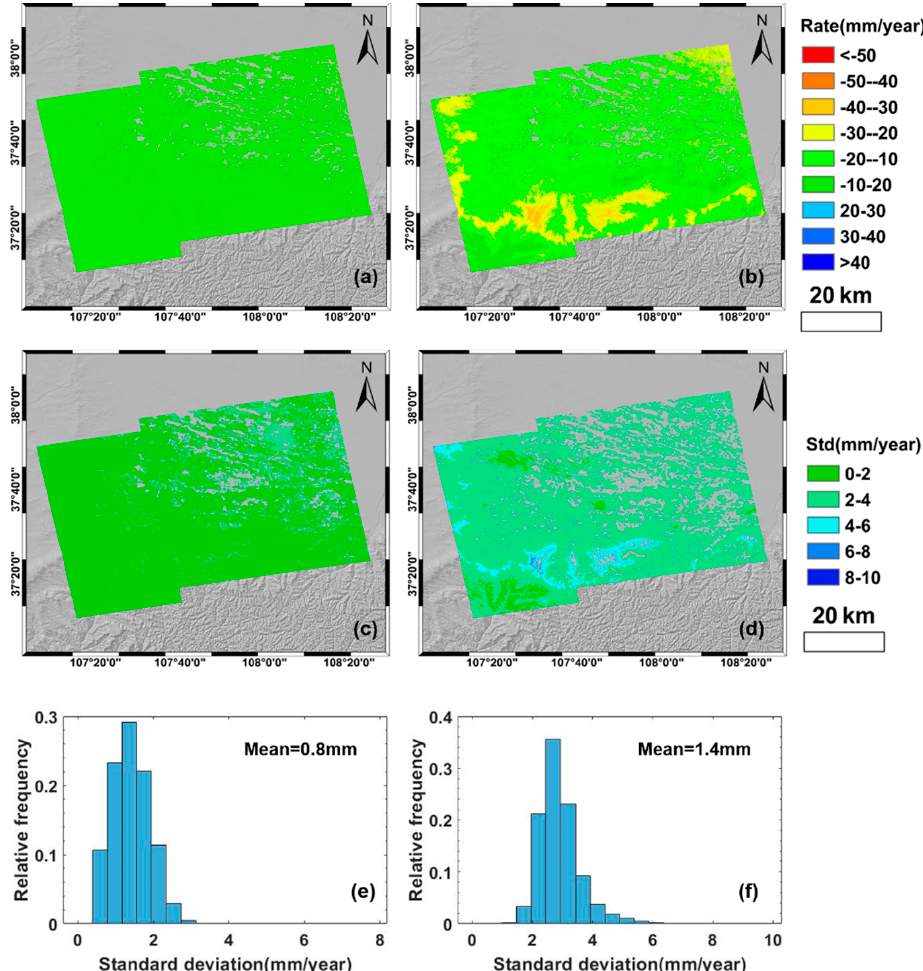
Figure A3. A comparative results of SAR datasets from frame 120 for deformation rate ( a , b ), standard deviation of the deformation rate ( c , d ) and histogram of the standard deviation ( e , f ) for two processing methodologies: QT − SP and LM − DT. The left column shows QT − SP results; the right column shows LM − DT results. Note that the results in both columns are based on the corresponding interferogram network selected by the method proposed in Section 3.2.2.